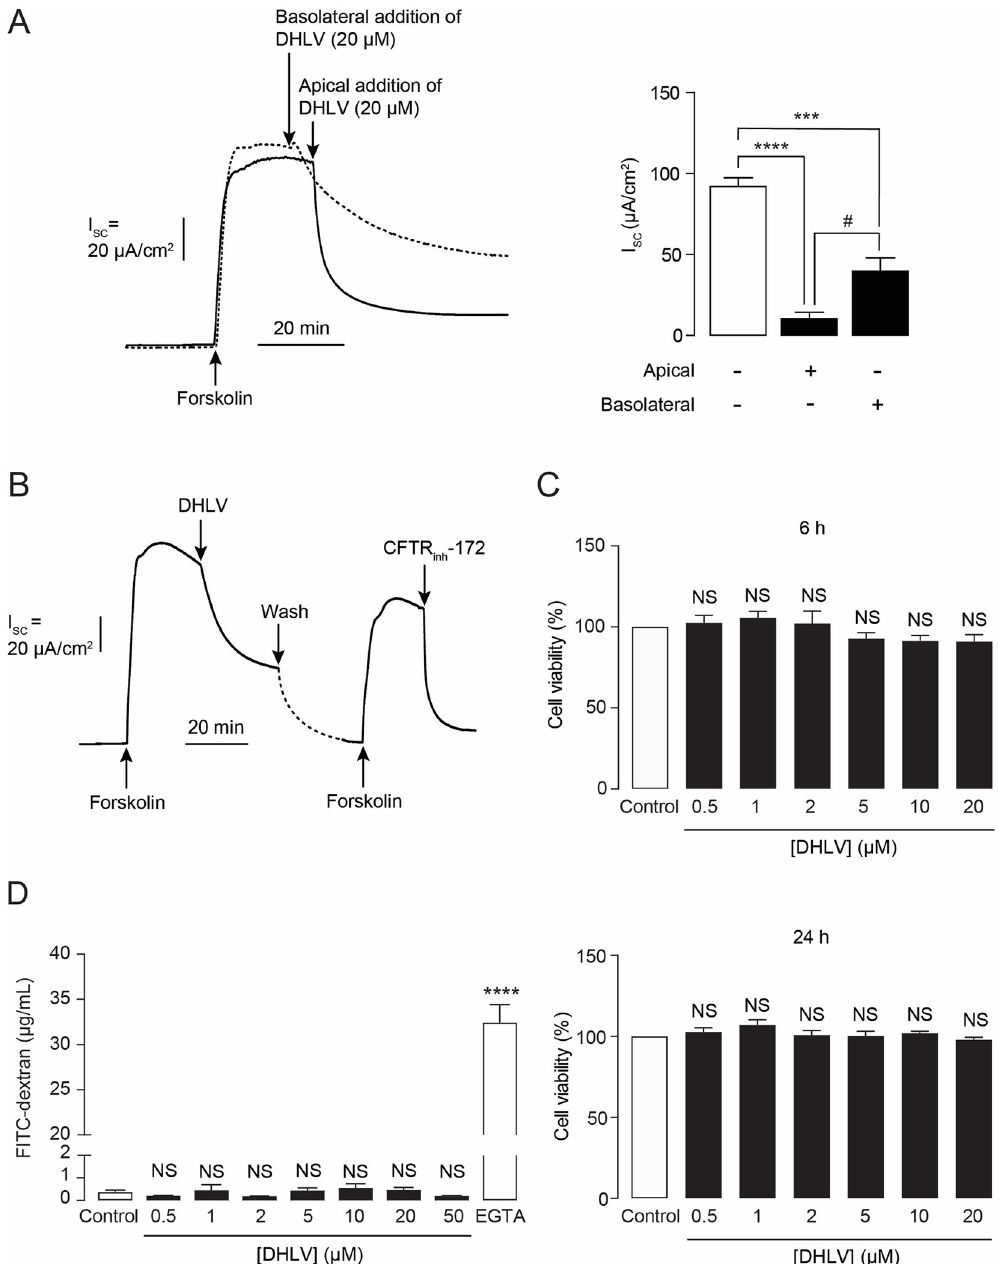
Fig 3. Effect of α , β -dehydrolovastatin (DHLV) on cAMP-dependent Cl - secretion, cell viability and barrier function in T84 cell monolayers. (A, left) Polarity of inhibition by α , β -dehydrolovastatin (DHLV) on cAMP-dependent Cl - secretion determined by I SC analysis. DHLV (20 μ M) was added into apical and basolateral solutions in a separate experiment. Representative I SC tracings are shown. (A, right) Summary of the data expressed as mean of I SC ± S.E.M. ( n = 5). (B) Reversibility of inhibition of CFTR-mediated Cl - secretion by DHLV (2 μ M) in T84 cell monolayers. After the inhibition of CFTR-mediated Cl - secretion was stabilized, the bathing solution containing forskolin and DHLV was removed. Both chambers were gently washed 5 times and bathing solution containing forskolin were re-filled into the chamber. At the end of experiment, CFTR inh -172 (20 μ M) was added into the apical chamber. A representative tracing of 3 independent experiments is shown ( n = 3 ) (C) Effect of DHLV on cell viability evaluated by MTT assays. T84 cells were treated with DHLV at the indicated concentrations for 6 or 24 h (upper, lower). Data are expressed as % of cell viability compared to control ± S.E.M. ( n = 4–6). (D) Effect of DHLV on intestinal barrier function. FITC-dextran flux assays were performed after 6 h of incubation with DHLV (20 μ M). EGTA (3 mM) was used as a positive control. Data are expressed as concentration of FITC-dextran ± S.E.M. ( n = 5–6). NS, non-significant; ���� p < 0.0001 compared with control.